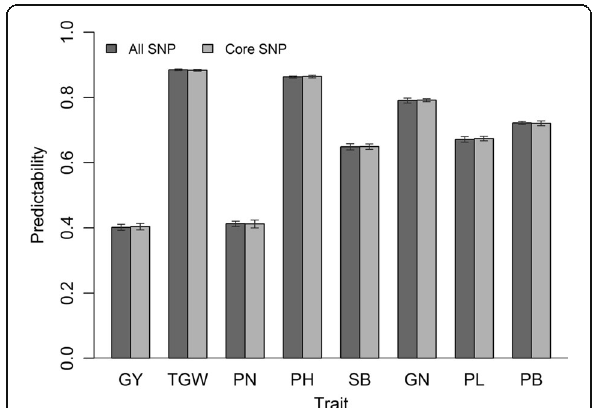
Fig. 1 Predictabilities of eight traits from two subsets of SNPs. All SNP defines the intersection of our rice SNP dataset and 3kRG filtered SNP set, including 2,054,293 SNPs; Core SNP defines the intersection of our rice SNP dataset and core SNP set, including 116,482 SNPs. Error bars are constructed using one standard error from the